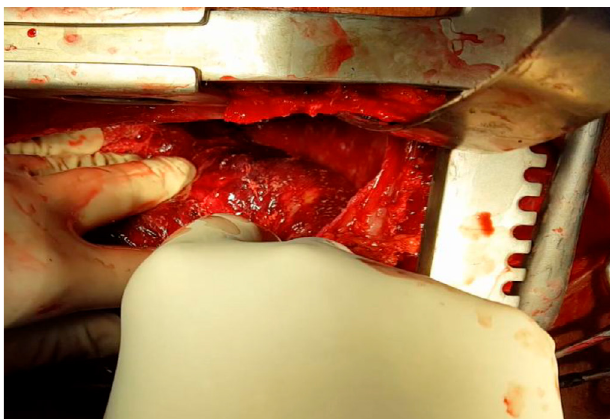
Fig. 2 – Hematoma in the posterior region of the left ventricle associated with epicardial